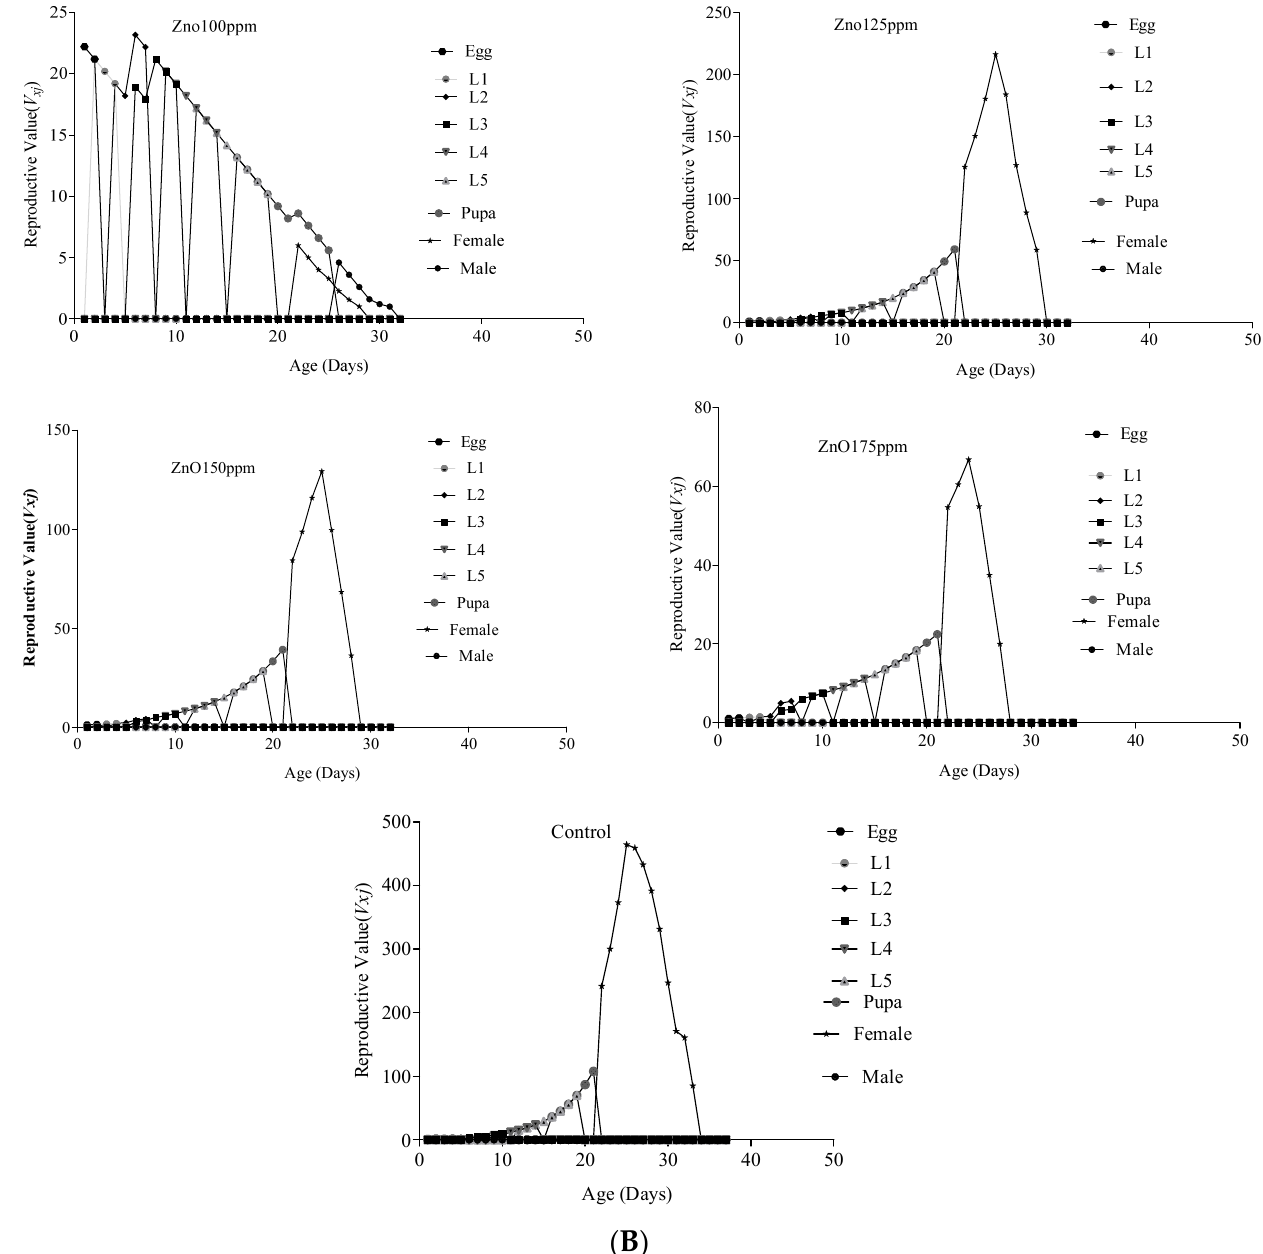
Figure 5. ( A ) Age-stage reproductive rate ( V xj ) of 100, 125, 150, 175 ppm and control of NPs treated H. armigera. ( B ) Age-stage reproductive rate ( V xj ) of 100, 125, 150, 175 ppm and control of NPs treated H. armigera.